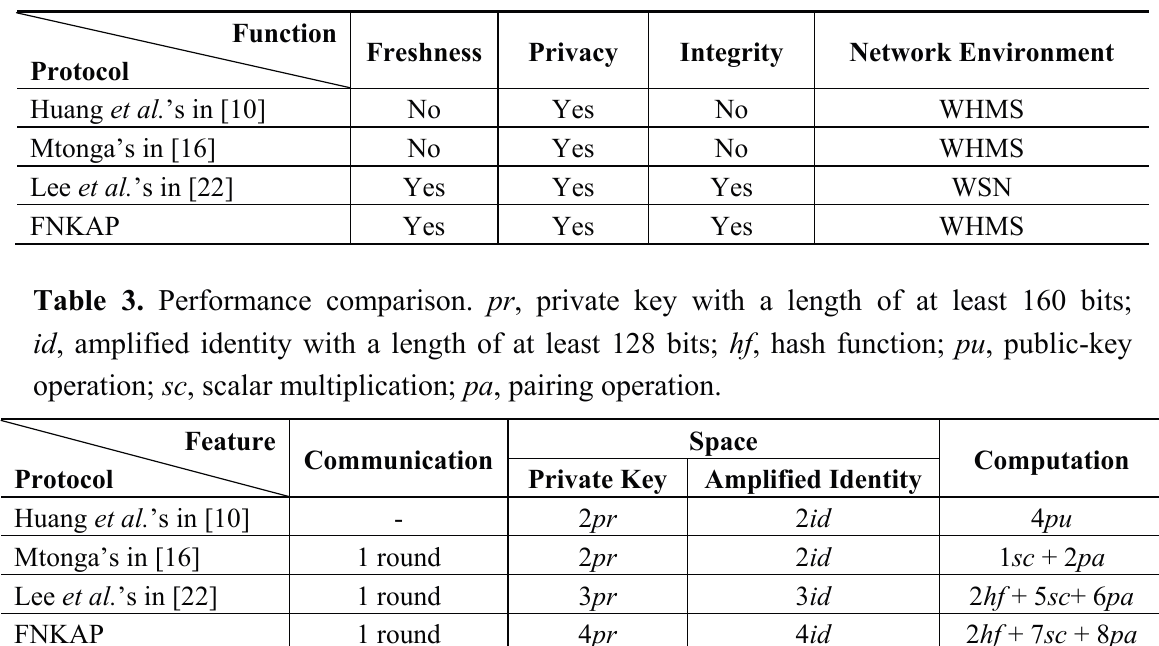
Table 2. Functionality comparison.